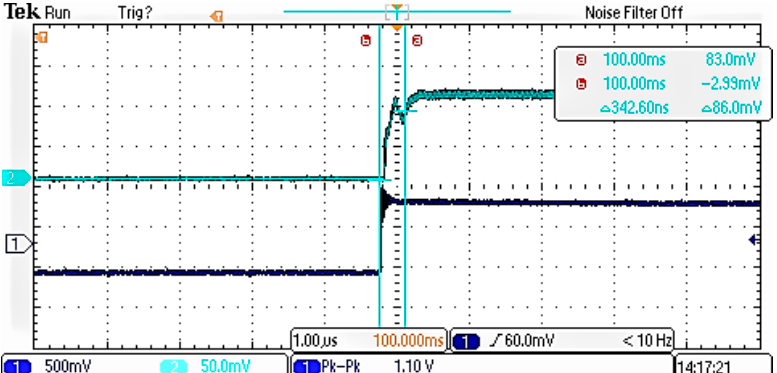
Figure 11. Switching speed of the improved series-shunt switch.